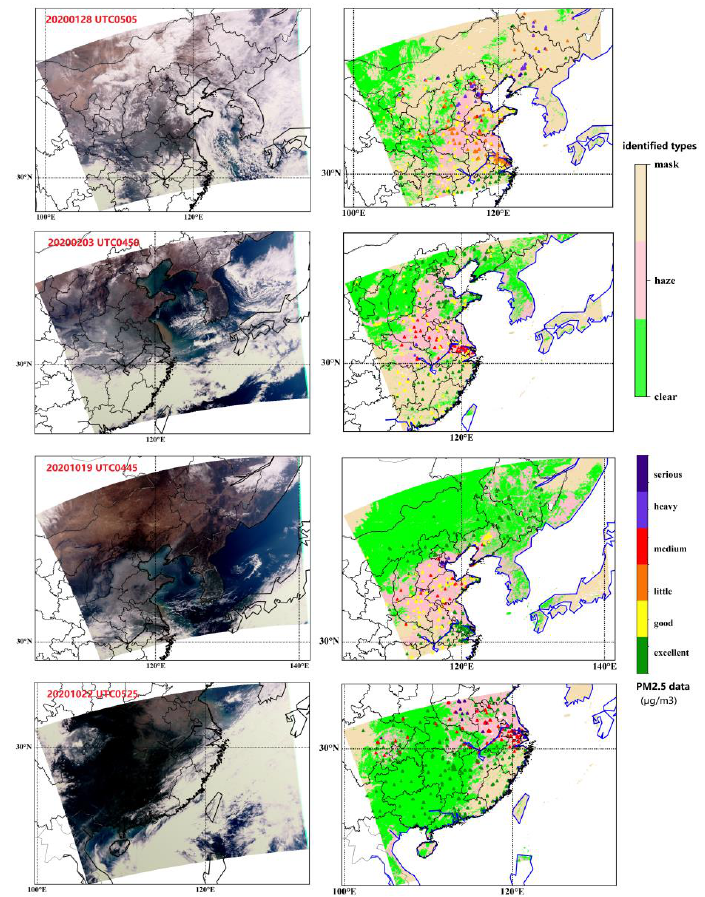
Figure 10. True color map and identified distribution overlaid with the national PM 2.5 monitoring data (unit: μg/m 3 ). PM 2.5 values belonging to excellent, good, little pollution, medium pollution, heavy pollution and serious pollution are marked as green, yellow, orange, red, purple and dark purple, respectively.